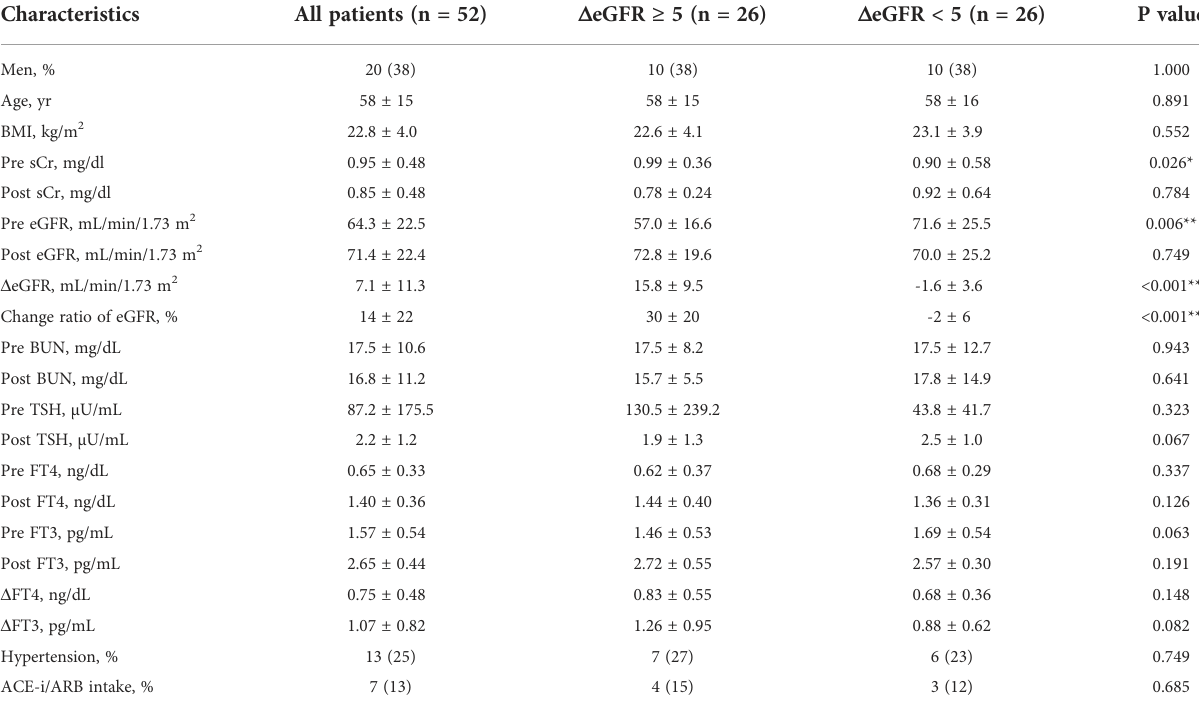
TABLE 5 Characteristics of study participants divided by D eGFR (<5 and ≥ 5) in hypothyroidism. Characteristics